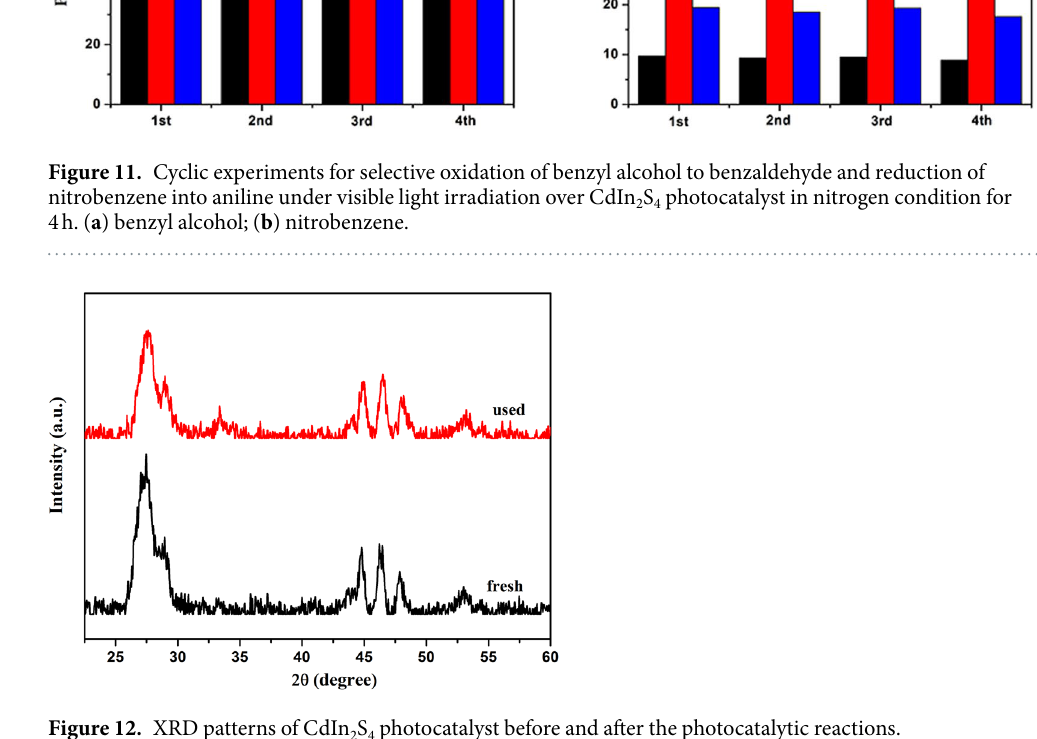
1.57 eV vs. NHE, respectively. The experimental test values obtained here are close to the result of the theoretical calculation of DRS analysis. In order to examined the feasibility of the photocatalytic redox reaction, the redox potentials of benzyl alcohol (BA), benzaldehyde (BAD), and nitrobenzene (NB) with different concentrations (0.1, 0.2, 0.5 mmol/L) were evaluated using cyclic voltammetry, respectively. As shown in Fig. 13d, the cyclic voltammogram of BA has two oxidation potentials. The first oxidative potential is BA to BAD at ca. + 0.48 eV vs. Ag/AgCl, and the second one belongs to BAD/corresponding acid. The oxidative potential is ca. + 1.89 eV vs. Ag/AgCl, which is shown in Fig. 13e. In addition, the reductive potential of NB is − 0.69 eV vs. Ag/AgCl (displayed in Fig. 13f). It is known that the conduction band of CdIn 2 S 4 photocatalyst by Mott-Schottky experiments is − 0.90 eV vs. Ag/AgCl, which is more negative than reductive potential of NB. The valence band is 1.37 eV (vs. Ag/AgCl) and is more positive than oxidative potential of BA to BAD, but is inadequate to oxidize BAD into benzoic acid. Therefore, the selective oxidation BA to BAD and reduction of NB to aniline can be achieved using CdIn 2 S 4 photocatalyst in a coupled system under visible light illumination. These results are supported by the theory calculation and are also consist- ent with the experiment results. Reaction mechanism.